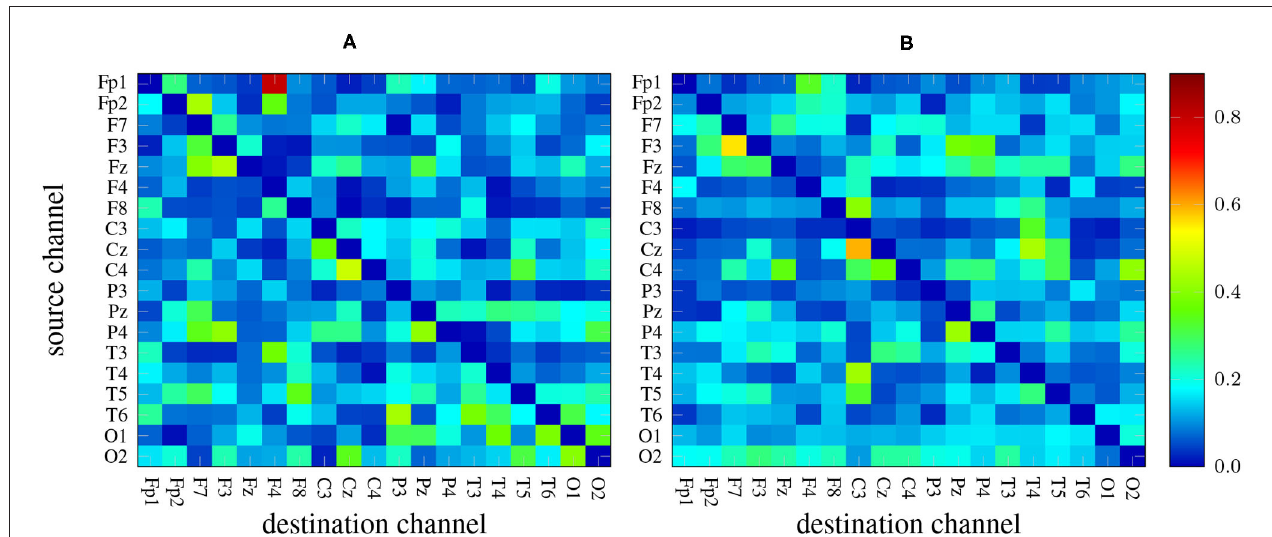
FIGURE 2 | GPDC samples computed in the alpha band of a 1-minute EEG recording coming from a patient (A) and from a healthy subject (B) . Red color indicates high values whereas dark blue color represents lower values.